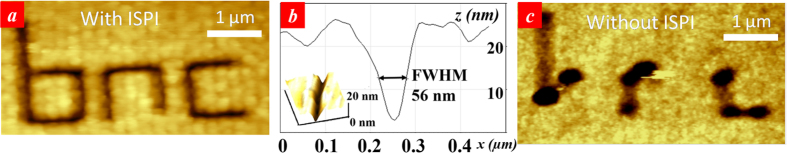
(a) AFM image of lithography result of letters “bnc” with alignment using ISPI technique, (b) the cross sectional profile of the line pattern. (c) A typical lithography results of letters “bnc” without using ISPI alignment.